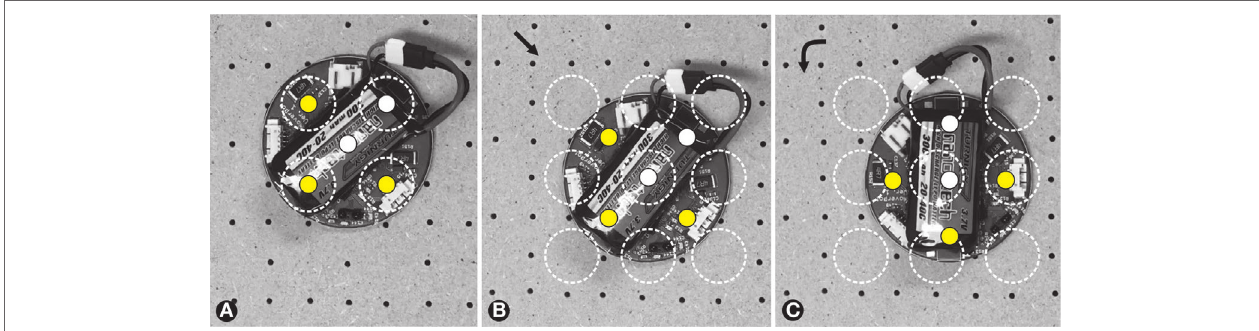
FigUre 6 | Recovery in locked position. (a) A HoverBot is locked in a 45°-angled position. Four of its five coils are aligned with permanent magnets. (B) The HoverBot rapidly pulsed (only) its center coil and regained center coil alignment with a permanent magnet. (c) The HoverBot additionally actuated a side coil and regained a slightly shifted idle position. At this stage, the HoverBot is reenabled to move.